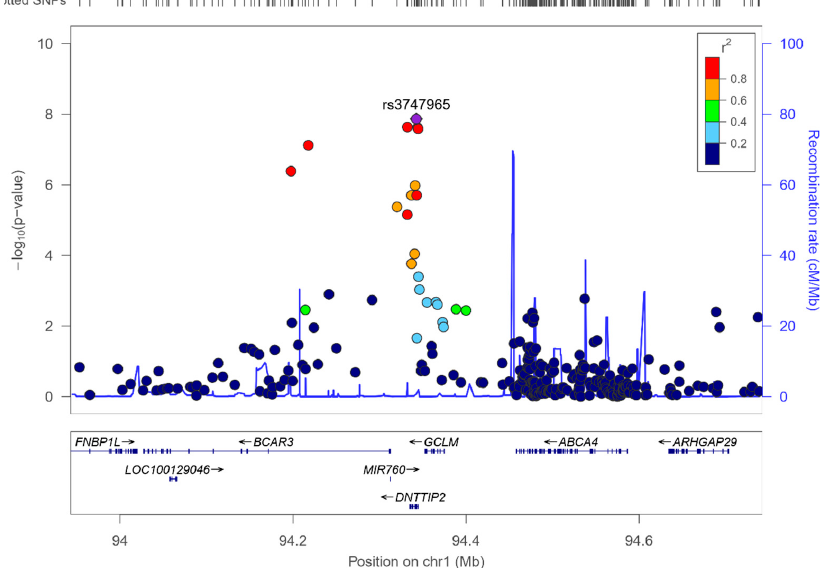
Figure 8. Regional plot for the top-ranked SNP rs3747965 (hit in the genome-wide interaction study with sex in determining serum polyunsaturated fatty acids), located in the DNTTIP2 gene, on chromosome 1. Results for the whole population.